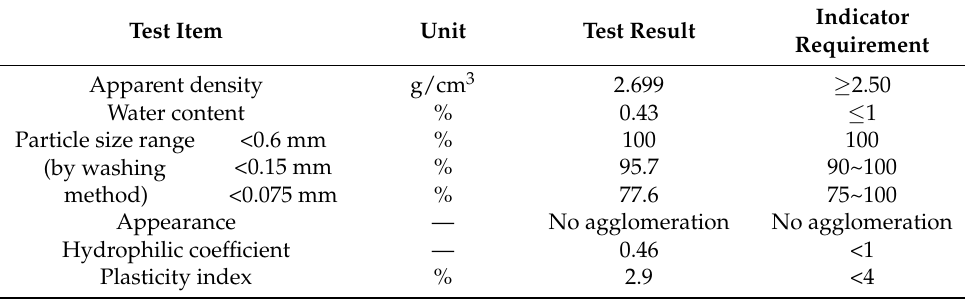
Table 6. Technical indicator requirements and test results of limestone powder.